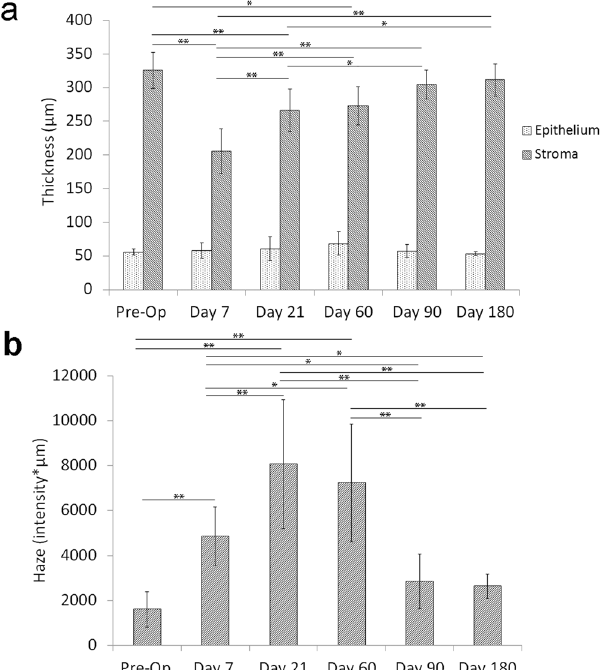
Figure 2. Measurements from in vivo confocal scans. ( a ) Epithelial and stromal thickness at each time point. ( b ) Stromal haze calculated at each time point. (ANOVA between groups, * P < 0.05, ** P < 0.001).